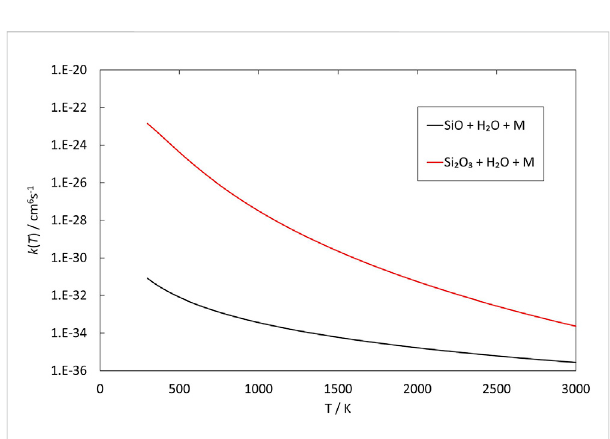
FIGURE 7 Rate coef fi cients ( fi t to RRKM calculations) of recombination reactions involving SiO and Si 2 O 3 reacting with H 2 O as a function of